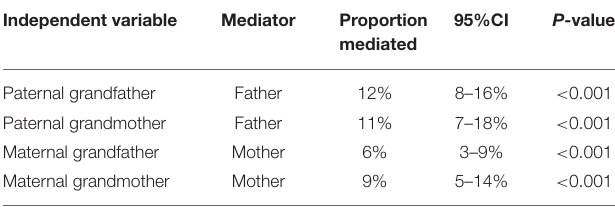
TABLE 2 | Mediation effect of parental asthma between grandparental asthma and childhood